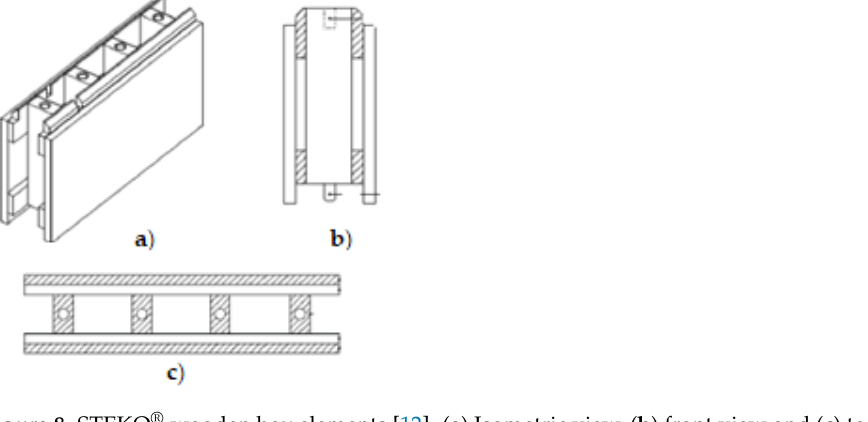
Figure 8. STEKO® wooden box elements [12]. ( a ) Isometric view, ( b ) front view and ( c ) top view.